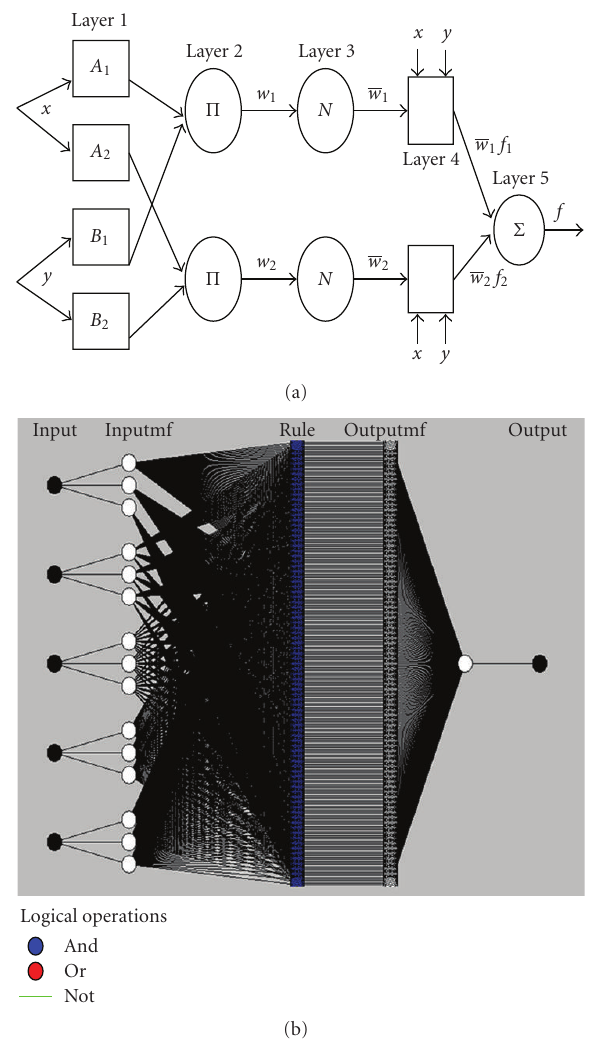
Figure 7: (a) ANFIS architecture [25]. (b) ANFIS architecture.